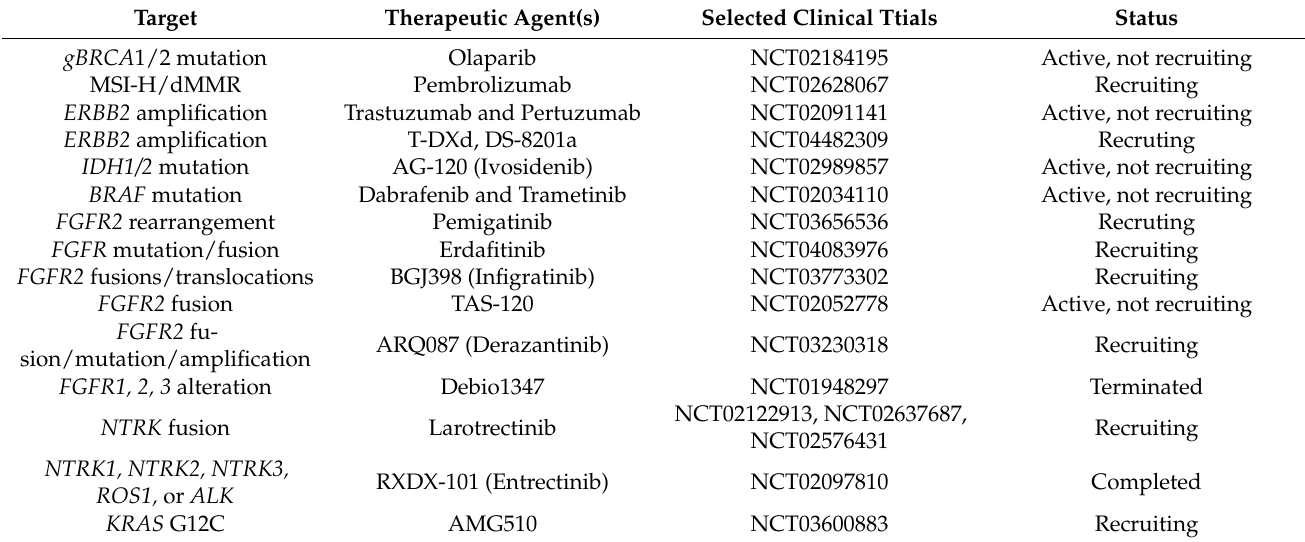
Table 2. Clinical trials for druggable mutations in pancreatic cancer and biliary tract